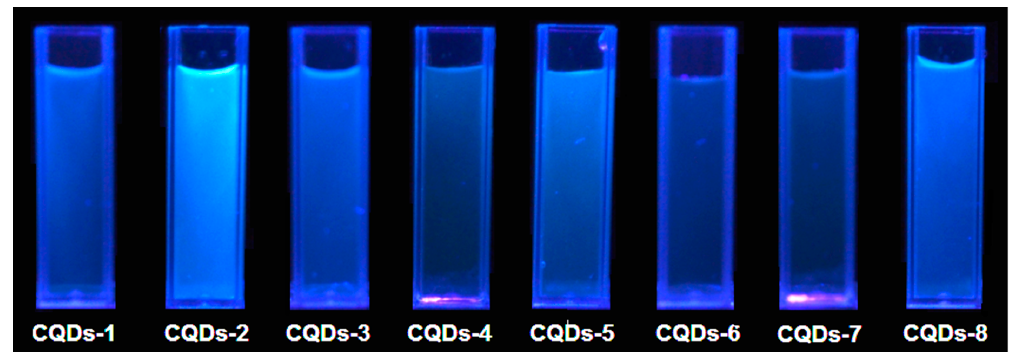
Figure 7. Prepared CQDs irradiated with the diode (365 nm).